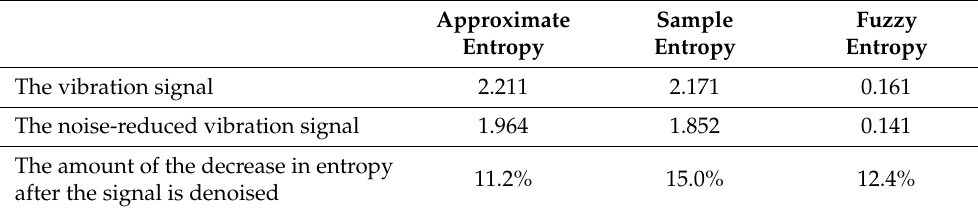
Table 2. Entropy values of vibration and noise reduction signal in Case